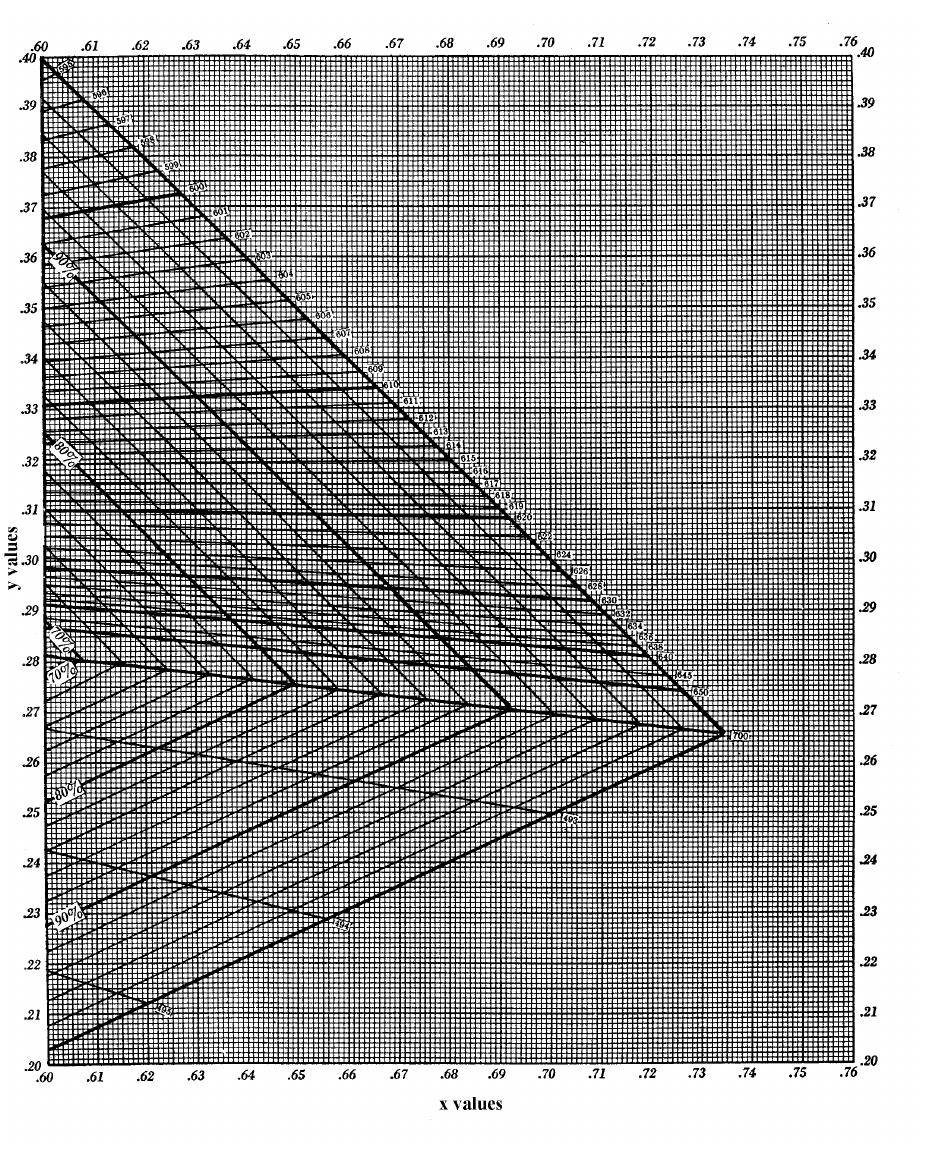
Chromaticity diagram for pure red wines and purple red